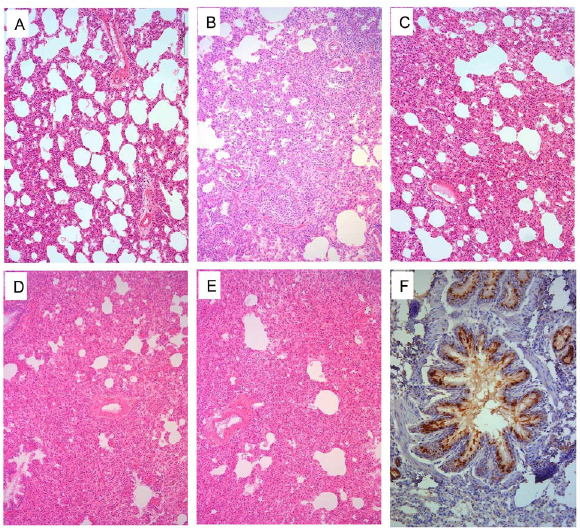
Figure 5. Histological lesions caused by H9N2 viruses in the lungs of ferrets. Ferrets were euthanized on day 4 p.i. with 10 6 EID 50 of test virus, and the lungs were collected for pathological study. The lungs of CK/ZJ/C1219/10 virus-inoculated animal showed only mild histopathological changes (H&E staining,) ( A ), whereas the lungs of CK/ GX/C1435/12 ( B ), CK/JS/C4258/12 ( C ), CK/ZJ/C1219/10-PB2/627K ( D ), and CK/ZJ/C1219/10-PB2/701N ( E ) virus-inoculated ferrets showed severe pathological lesions (H&E staining) Viral antigen was detected in the epithelial cells of bronchus and alveoli by means of immunohistochemical (IHC) staining ( F , from the lung samples of a ferret inoculated with CK/JS/C4258/12 virus). Images A–E were taken at 6 100 magnification; Image F was taken at 6 200